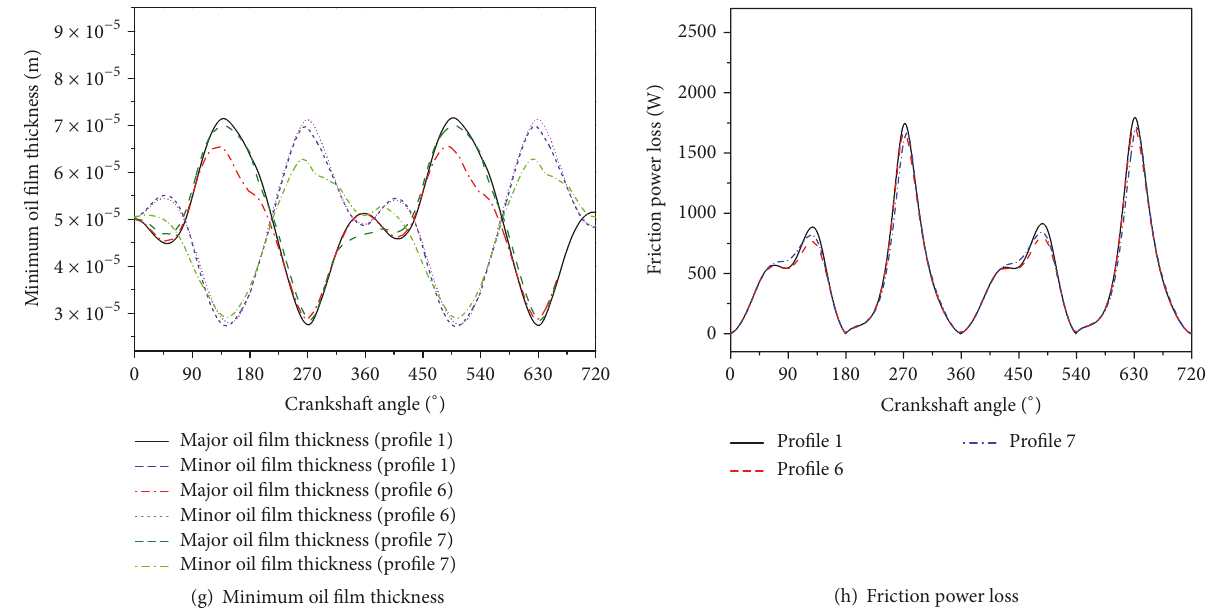
Figure 16: Effect of middle-convex point on lubrication performance.